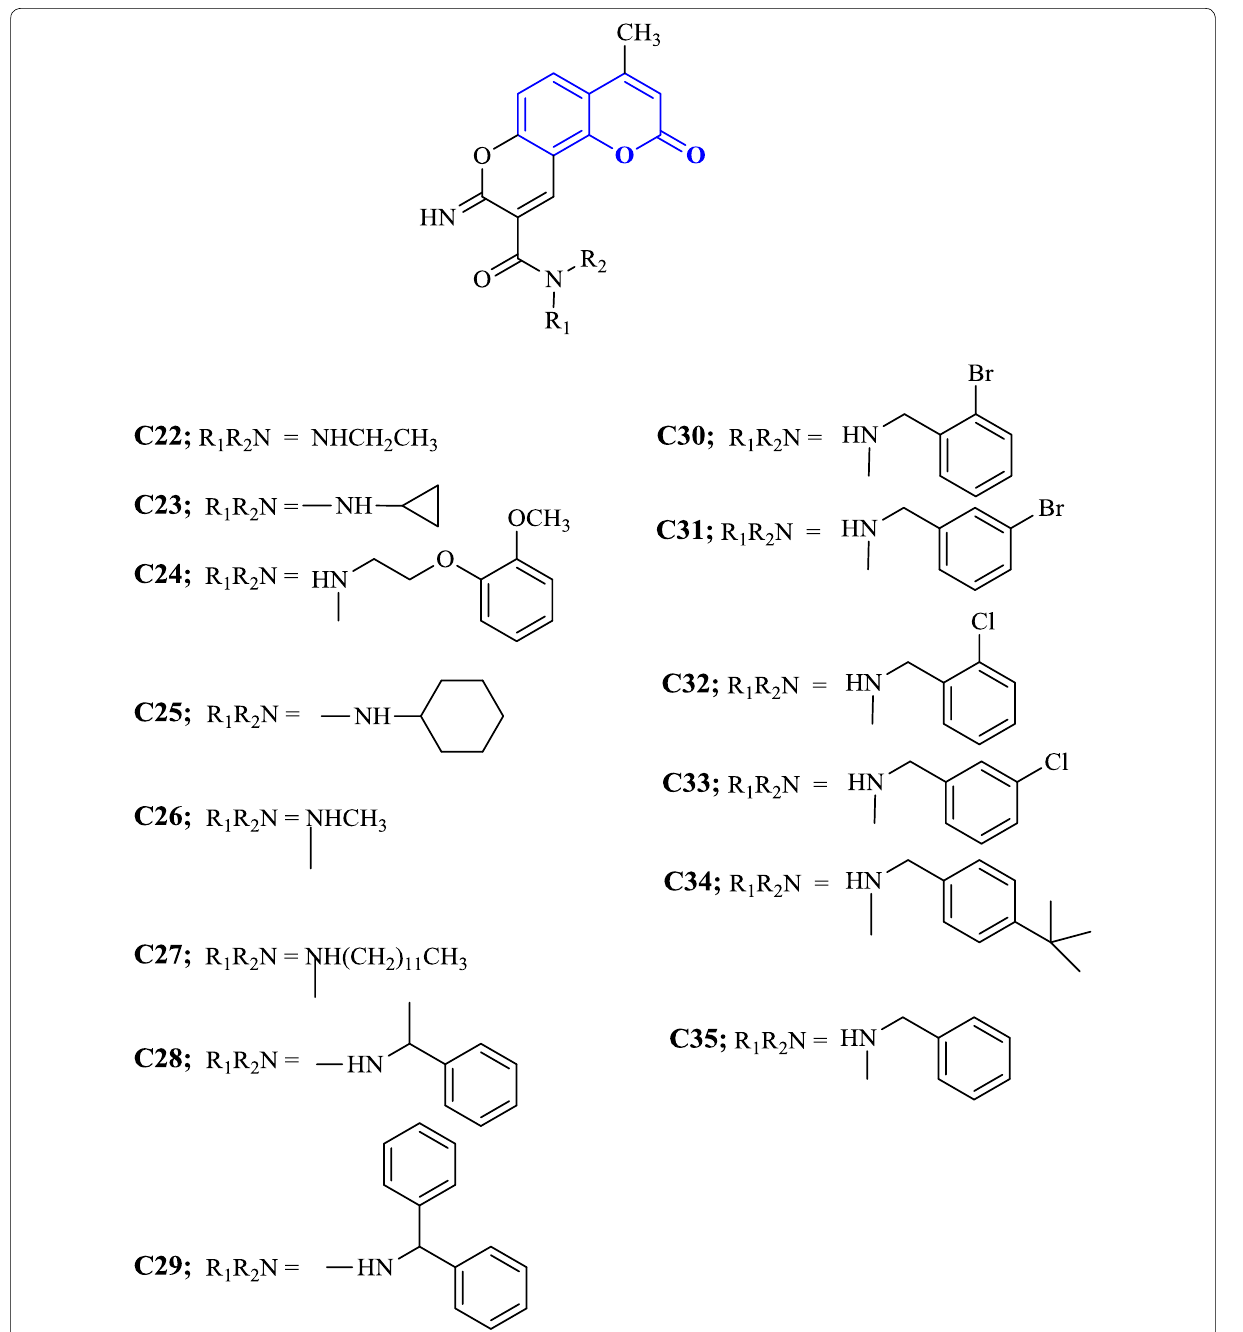
Fig. 30 Chemical structures of tricyclic coumarin derivatives C22 –